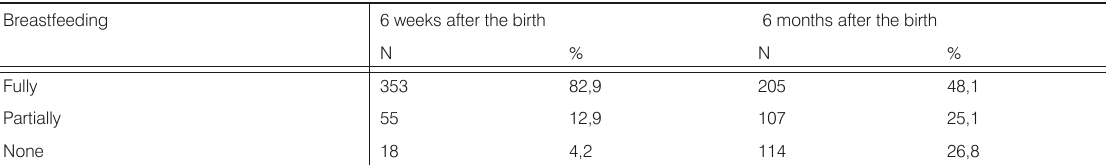
Table 2. Type of contraception used by sexually active couples at the beginning of sexual life and half a year after the birth.